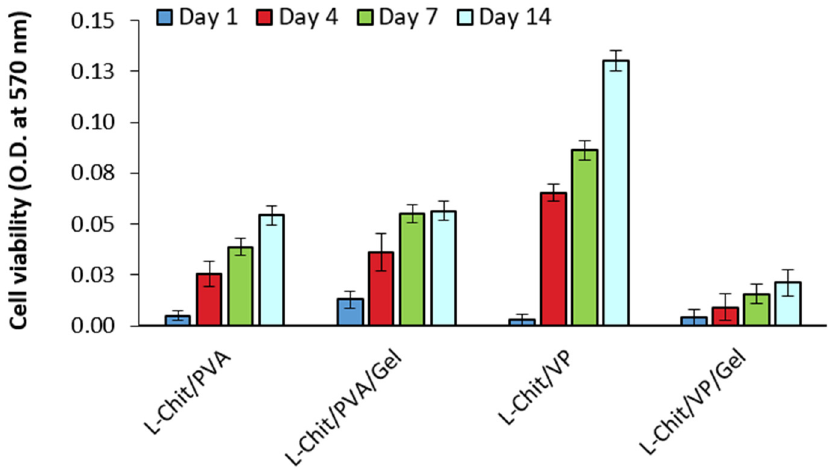
Figure 8. Cellular viability of HFFF2 growing on different substrates on culture days 1, 4, 7 and 14 ( n = 3; mean value ± SD).